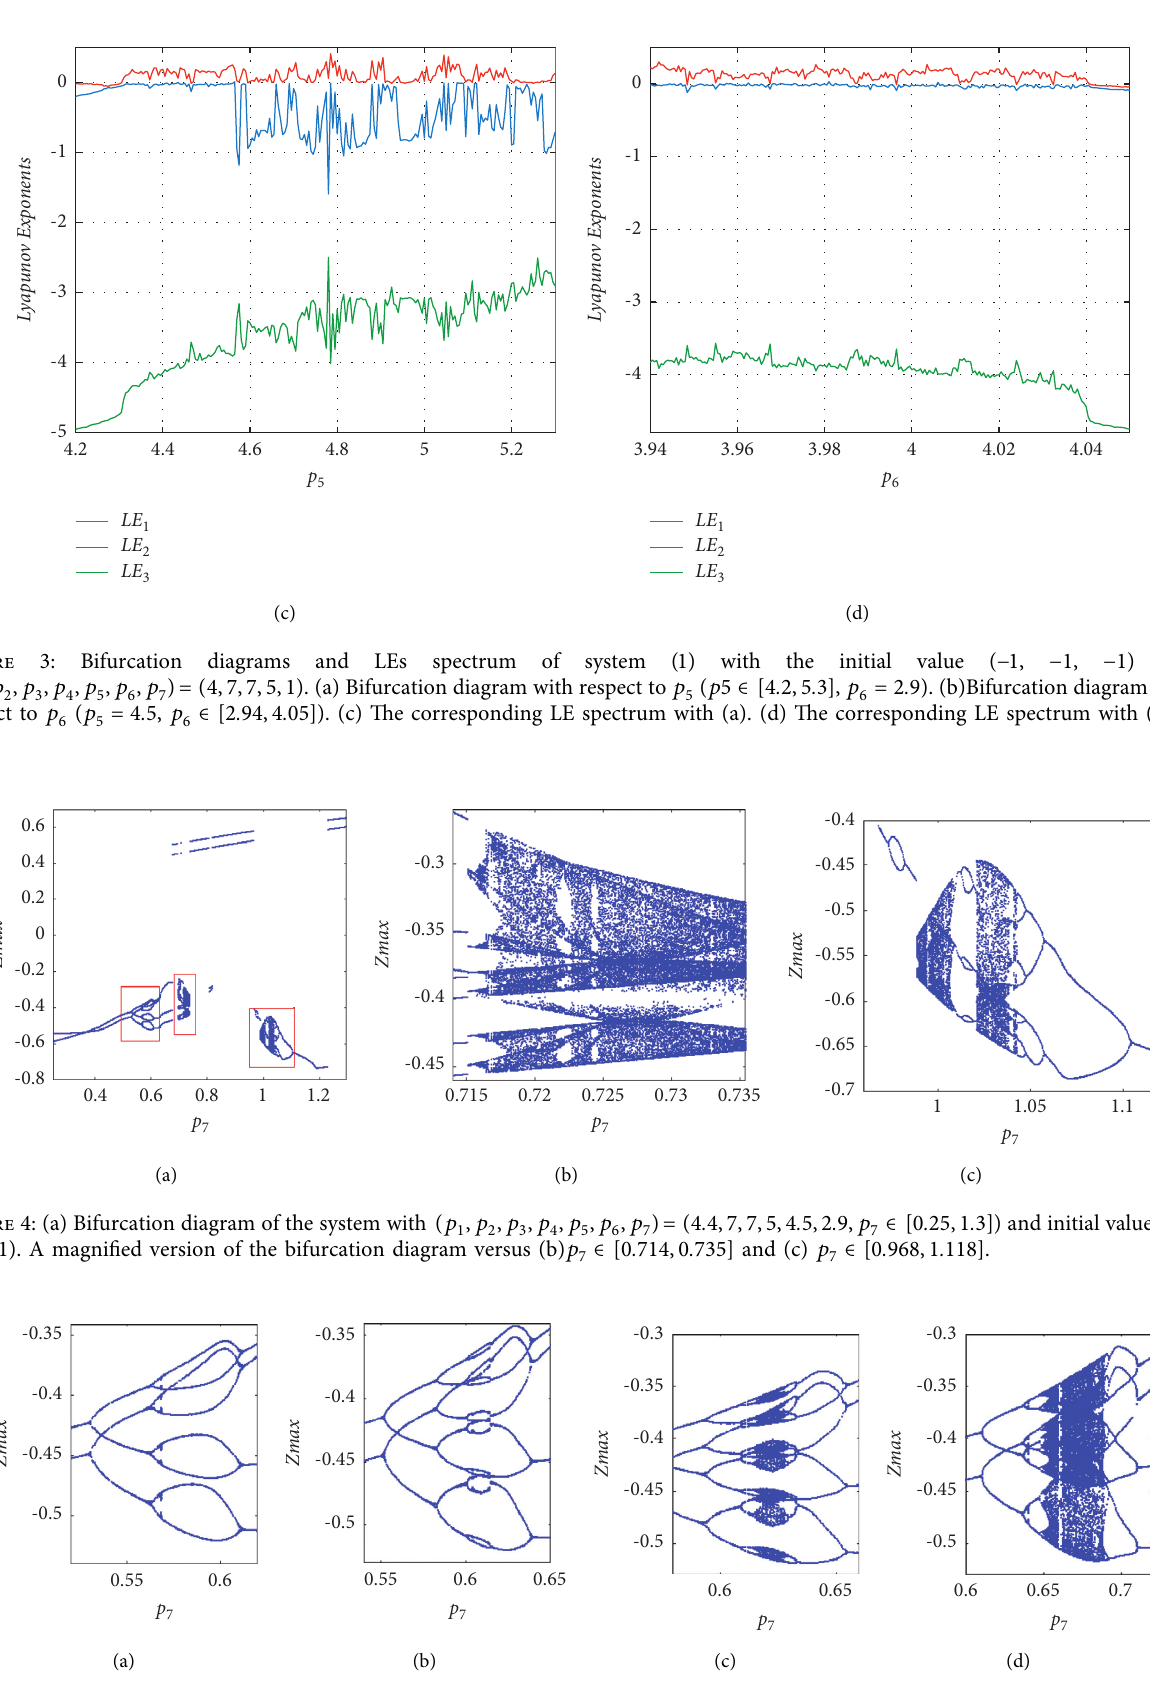
� 2.9; (b) period-4 bubble for p 6